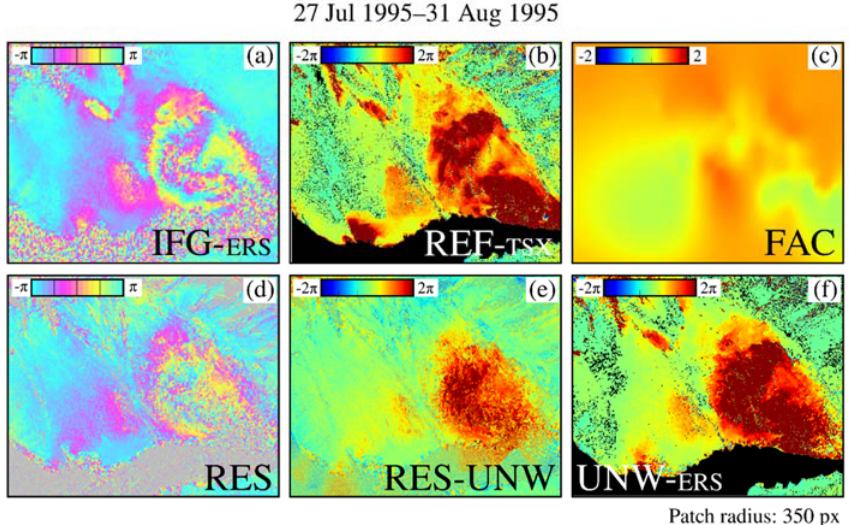
Figure 11. Warp demodulation result for a representative ERS interferogram (C-Band, 30 m ground range resolution, 35-day repeat cycle) covering 1 cycle. ( a ) IFG-ERS, to-be-demodulated interferogram (wrapped); ( b ) REF-TSX, reference interferogram (unwrapped); ( c ) FAC, demodulation factor; ( d ) RES: demodulation residual (wrapped); ( e ) RES-UNW: demodulation residual (unwrapped); and ( f ) UNW-ERS, demodulated interferogram. The unwrapped phase in ( b , e , f ) is clipped to ± 2 π . The demodulation patch radius is 350